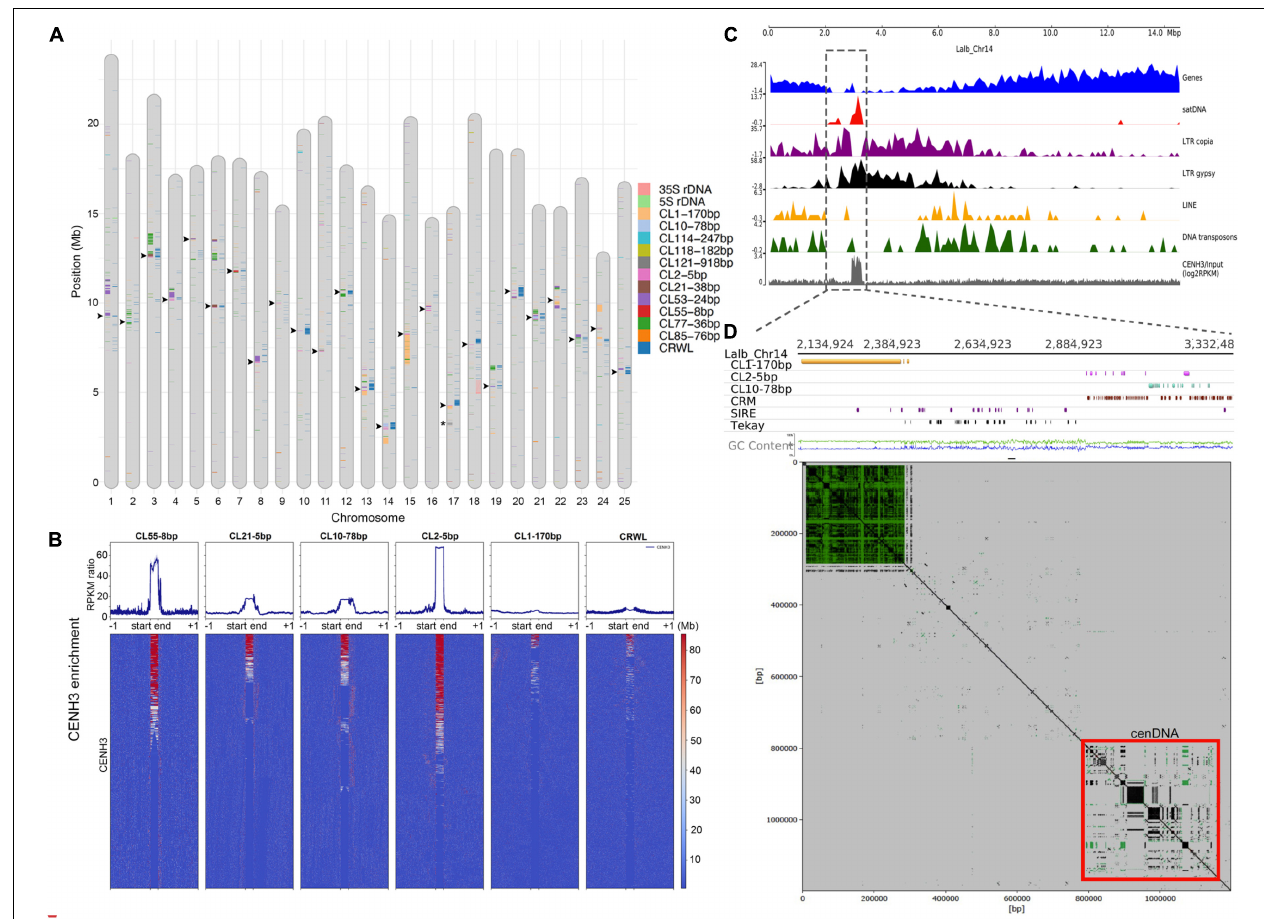
FIGURE 2 | Repeat Composition and Characterization of WL Centromeres. (A) SatDNA, rDNA, and CRWL annotation of the reference genome of WL ( L. albus cv. AMIGA). Arrowheads indicate the location of centromeres based on the CENH3-ChIPseq analysis. Asterisks indicate the chromosome-specific CL121-918bp satDNA array on Lalb-chr-17. (B) CENH3-ChIPseq enrichment profiles (RPKM ratio) for the centromeric satDNA families, CL1-170bp, and CRWL of WL. Note the specific high enrichment for CL2-5bp, CL10-78bp, CL21-38bp, and CL55-8bp. (C) Lalb_Chr14 as an example showing the enrichment for repeat sequences toward the proximal region. (D) A zoomed view of Lalb_Chr14 centromeric region, note that despite a large CL1-170bp array, the centromere function is specifically associated with a region enriched with CL2-5bp, CL10-78bp, and